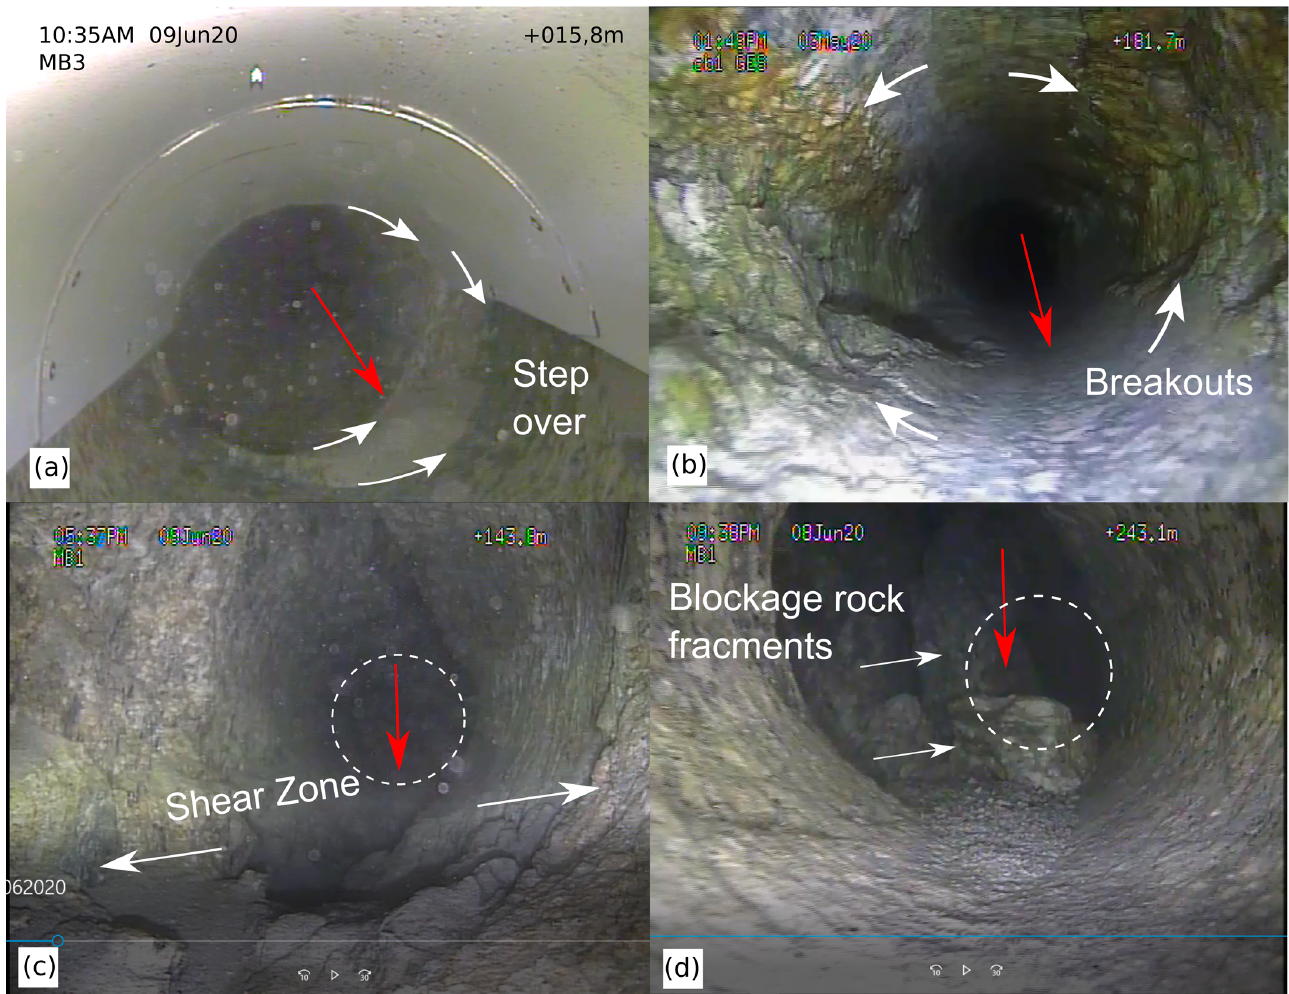
Figure 2. Quality of hectometer-scale boreholes with rough borehole contours: ( a ) step over at end of conductor pipe, ( b ) borehole breakouts, and ( c ) shear zones are common observations and major challenges for lowering monitoring equipment. In addition, ( d ) borehole blockage by rock fractures is not unusual. White arrows highlight features; red arrows point towards the borehole bottom, as the borehole camera is rotated. Pictures taken of monitoring boreholes MB1, MB3, and MB4 of the BRP project. Figure 2b modified from [17].